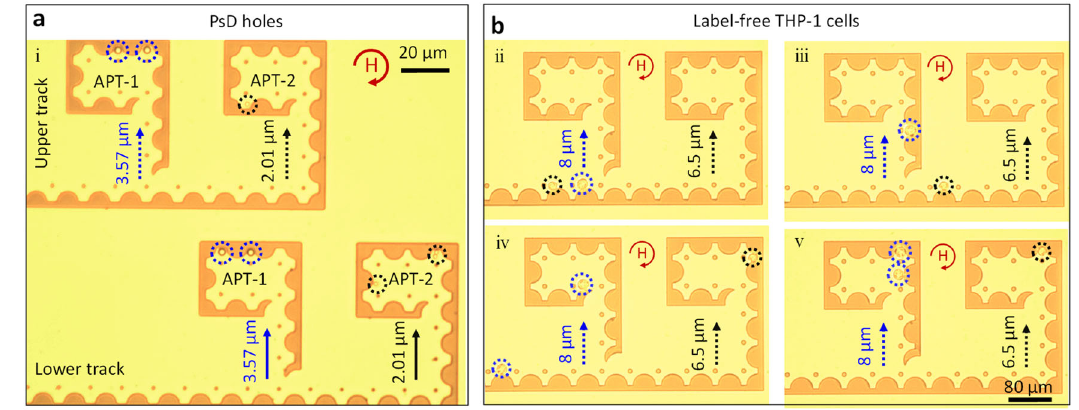
Fig. 7 Capacitors to store multiple PsD holes and cells. a Capacity storage of multiple PsD holes in single compartments arranged along upper and lower tracks. PsD holes 3.57 µ m (blue circles) and 2.01 µ m (black circles) in diameter occupied APT-1 and APT-2, respectively. b Bright- fi eld images of THP-1 cells 8 µ m (blue circles) and 6.5 µ m (black circles) in diameter sorted at the eclipse junctions and delivered to storage apartments APT-1 and APT-2, respectively. The curved arrow in red denotes the clockwise rotating magnetic